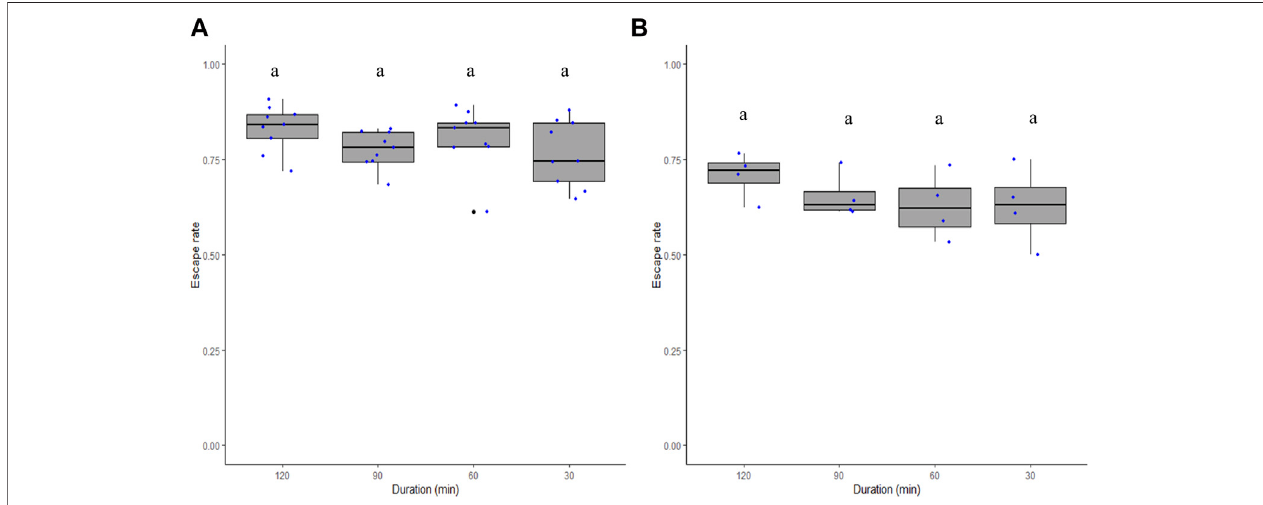
FIGURE3| Male Aedesaegypti (A) and Aedesalbopictus (B) escape ratesinresponsetotestduration. Fourtime periodsof30,60, 90,and 120 min weretested. Different letters denote signi fi cant differences between time